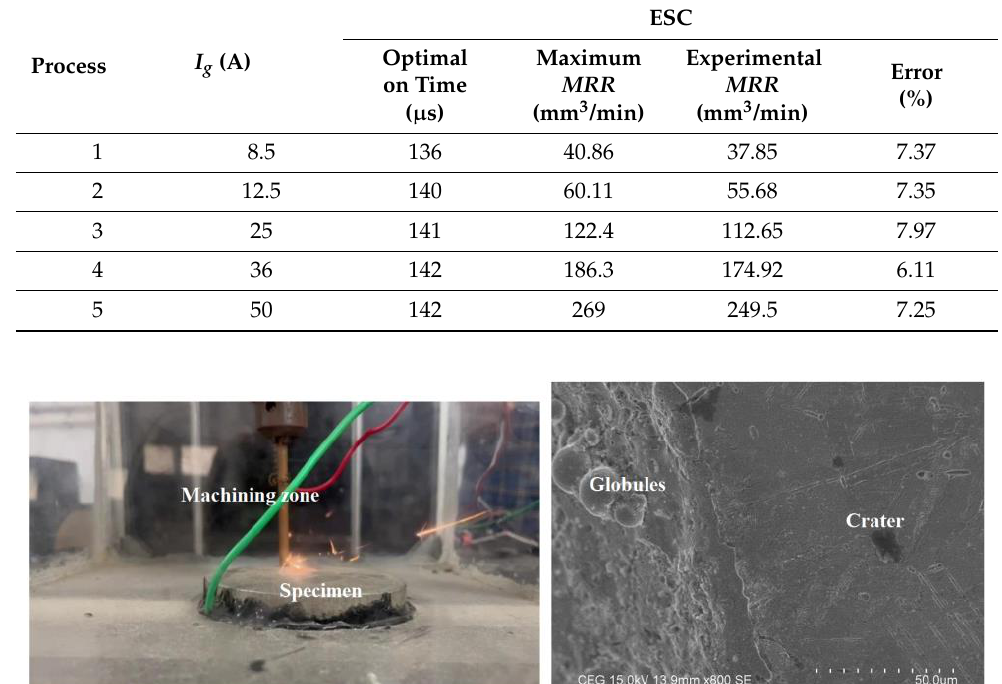
Figure 11. MRR comparison of manual and ESC searching. Table 3. Extremum-seeking of the MRR for gap currents.